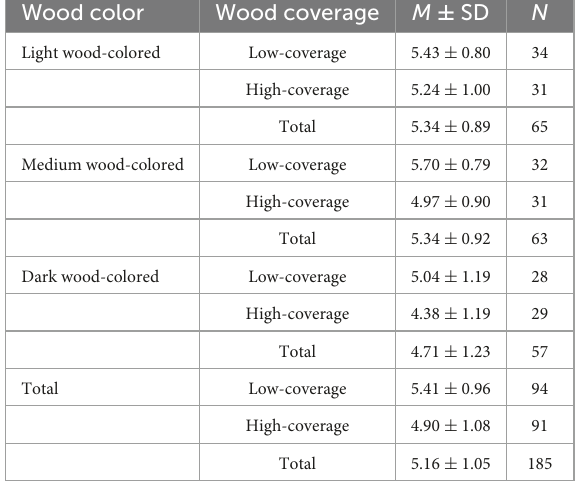
TABLE 3 The descriptive statistics and correlations between the